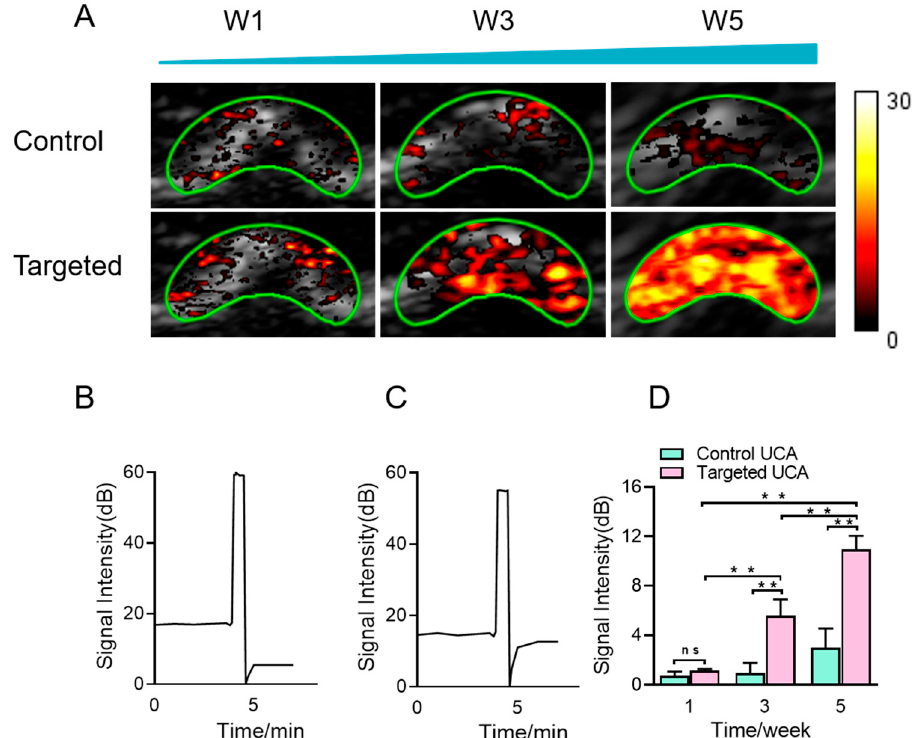
Figure 5. Ultrasound molecular imaging of ONFH in vivo. ( A ) Targeted and control MBs using for ultrasound molecular imaging in rat ONFH model (green borders: ROI borders) in rats. Color-targeted contrast signal was overlaid on gray brightness-mode (B mode) image. ( B , C ) Schematic diagram of targeted MBs and control MBs pre- and post-destruction. ( D ) Quantitative analysis of signal intensities for the targeted and control MBs. Data were analyzed by one-way ANOVA, and multiple comparisons of LSD were chosen as post hoc tests (** p < 0.05, ns means p > 0.05).